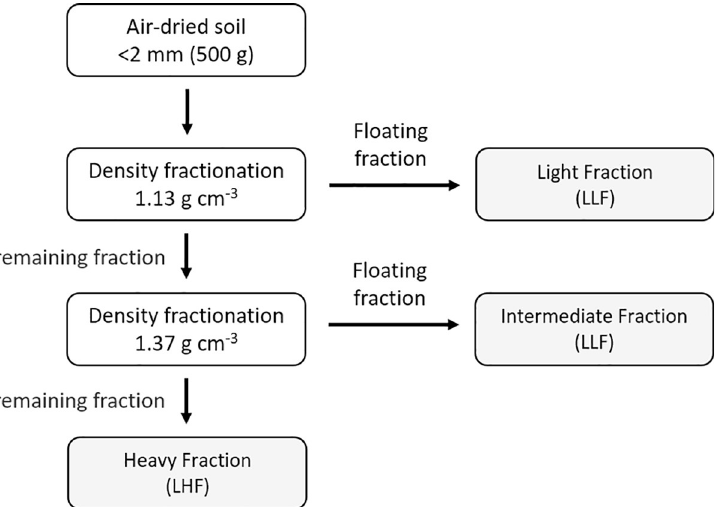
Fig 1. Schematic representation of size-density fractionation of